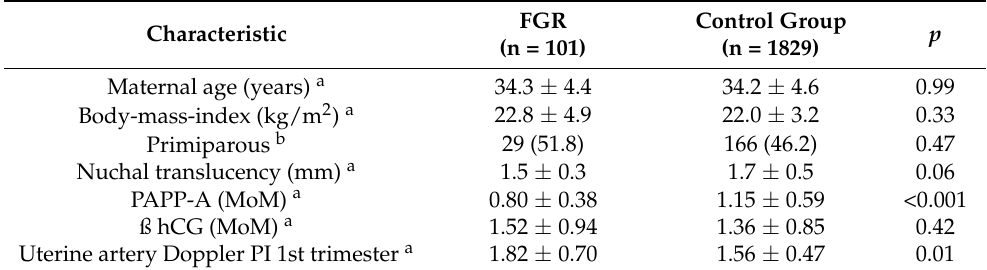
Table 2. Comparison between women with fetal growth-restricted fetuses (birth weight < 3% per- centile) and normal birth weight fetuses.